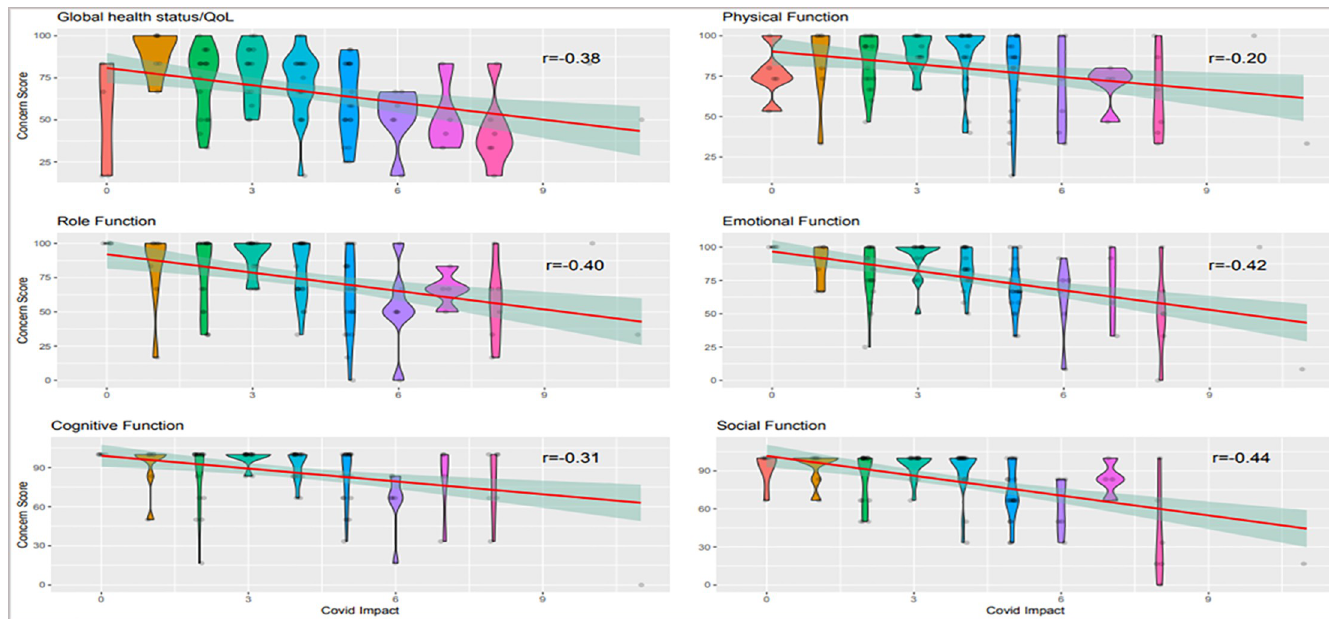
Fig 3. The violin/scatter plots depict the concern scores as a function of the Covid Impact for six health categories. The red line is a linear fit to the data alongside the 95% confidence intervals shaded in green. The numbers show the Spearman’s rho coefficient. All correlations are significantly negative (p < 0.05).